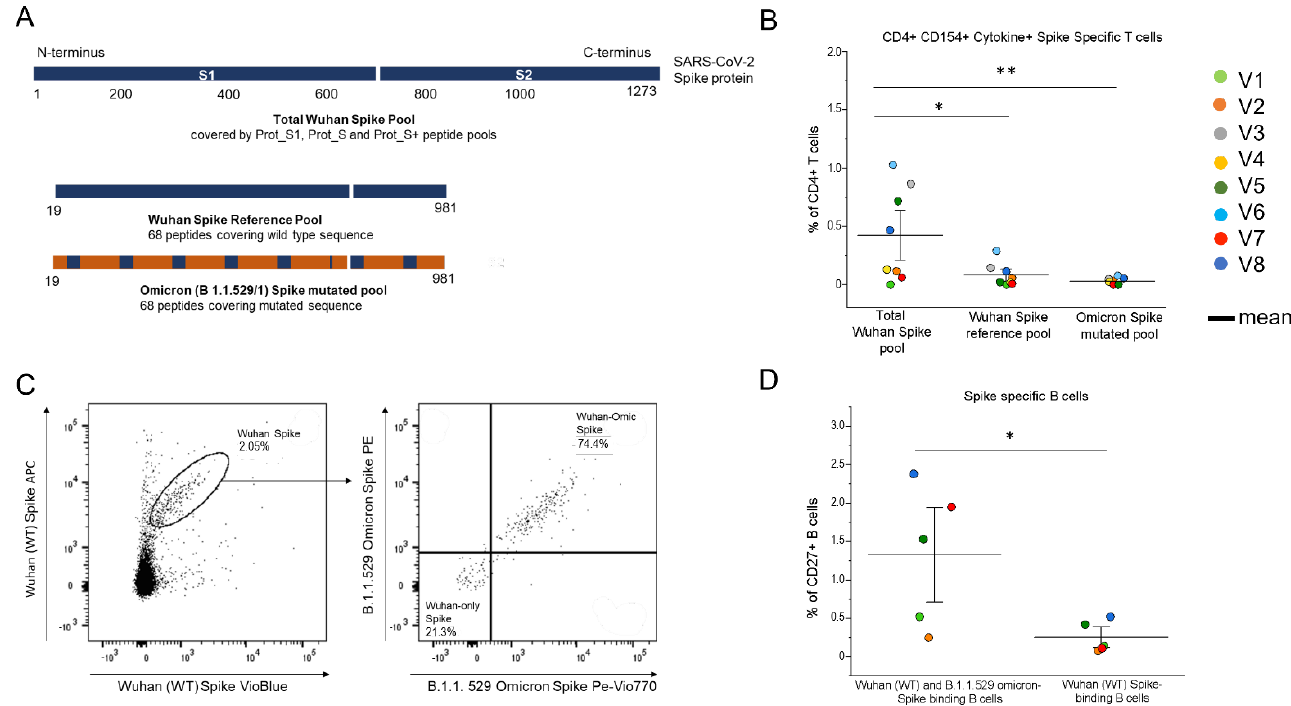
Figure 3. Assessment of the CD4+ T and B cells responses specific to the Wuhan SARS-CoV-2 spike and the B 1.1.529 SARS-CoV-2 VOC spike, 2 months after the administration of the fourth vaccine dose in eight vaccinated PLWH vaccinated . ( A ) Visualization of the SARS-CoV-2 spike protein (1273 aa) covered by the S1, S+ and S peptide pools, the wild type sequence and the mutated sequence (aa 19–981) in the Omicron B1.1. 529 (BA.1). All peptide pools contain 15-mer peptides, 11 aa overlapping. ( B ) The frequencies of the CD154+ cells producing at least 1 cytokine among IL-2, IFN- γ and TNF- α , stimulated with the spike peptide pool, wild type (Wuhan) or the B. 1.1.529 (Omicron) peptide pool covering the mutated sequence of the spike. ( C ) Representative plots of the identification of the Wuhan spike-specific, labelled with APC-PB, and the Omicron spike-specific B cells, labelled with PE-PeVio770 within the Wuhan spike-specific pool. ( D ) Frequencies of the spike specific memory B cells binding both the Wuhan spike and Omicron spike and the B cells binding exclusively to the Wuhan spike. Each color corresponds to a different subject. Black lines indicate mean values.* p ≤ 0.05, ** p ≤ 0.005. Error bars indicate SE